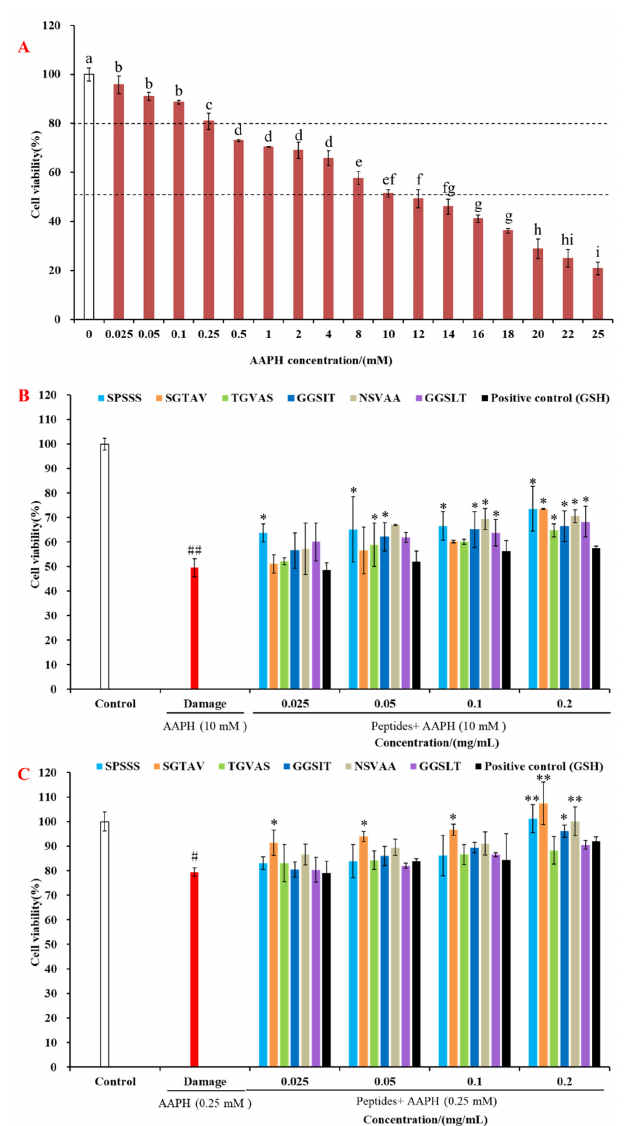
Figure 4. Cytoprotective effects of antioxidant peptides SPSSS, SGTAV, TGVAS, GGSIT, NSVAA, and GGSLT and positive control (GSH) against AAPH-induced stress injury in HepG2 cells. ( A ) Effects of different concentrations of AAPH on the cell viability. ( B ) Protective effect of antioxidant peptide in the 50% cell viability model. ( C ) Protective effect of antioxidant peptide in the 80% cell viability model. Different letters (a-i) indicated that the difference between the data was statistically significant ( p < 0.05). ## indicated p < 0.01 compared with the control group. # indicated p < 0.05 compared with the control group. ** indicated p < 0.01 compared with the AAPH damage group. * indicated p < 0.05 compared with the AAPH damage group.